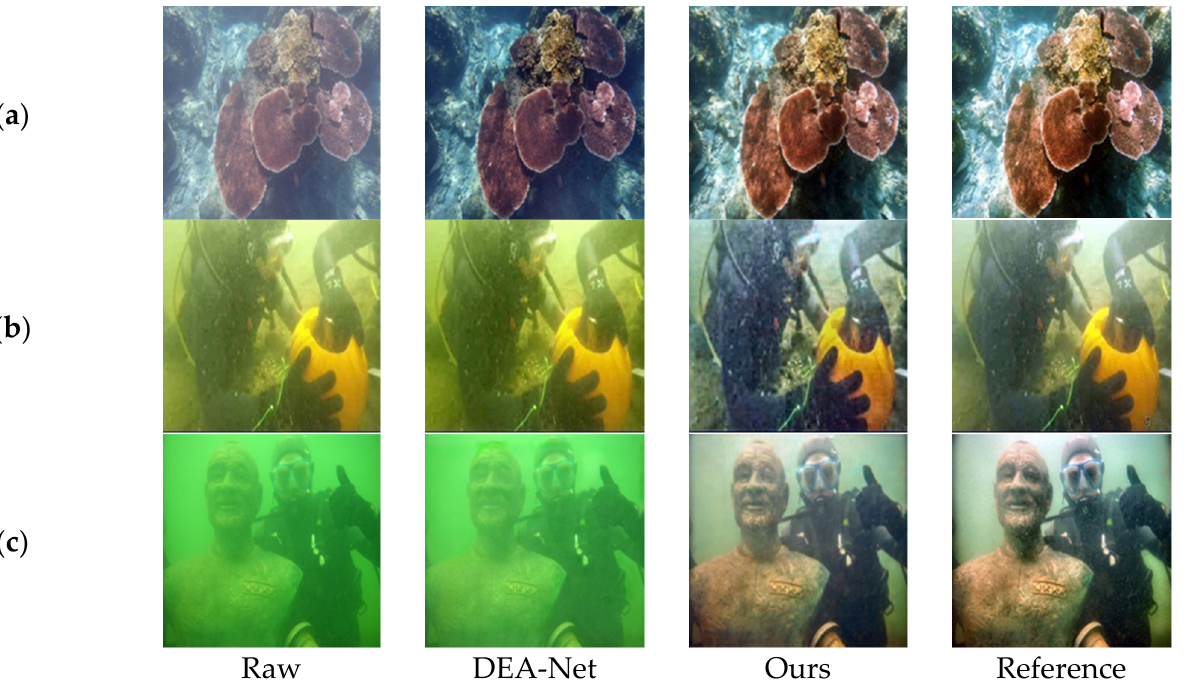
Figure 4. Comparison of DEA ‐ Net dehazing model with Our model on UIEB dataset.